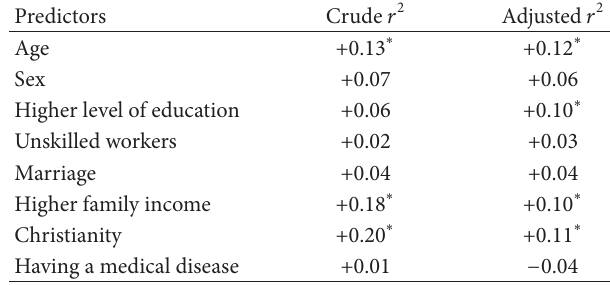
T 1: General characteristics of the study subjects.